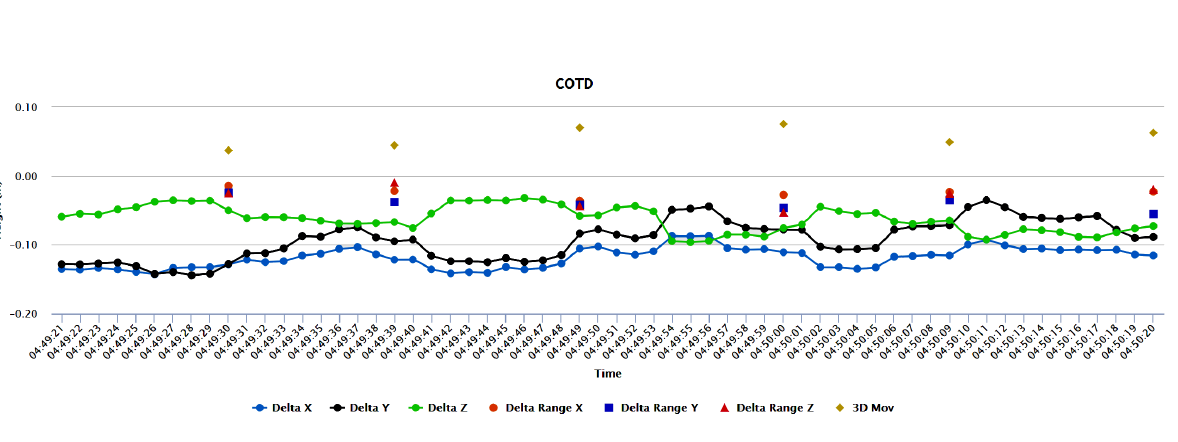
Figure 3. Real-time raw delta x, y, z and aggregated ranges for a SCIGN sensor